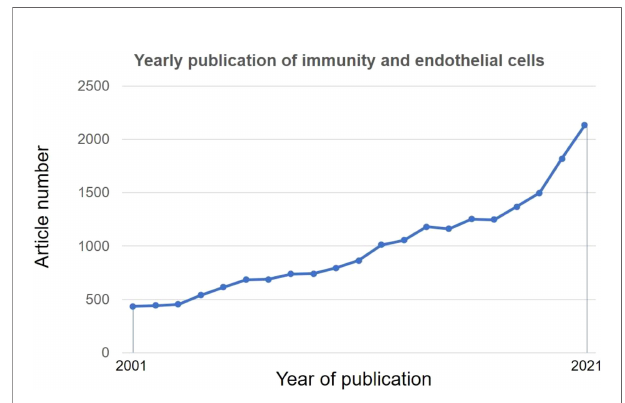
FIGURE 1 | Research trends of immune functions of endothelial cells. A literature search was performed in PubMed using subject terms: “ Immune ” OR “ Immunity ” AND “ endothelial cell ” . Data were retrieved on May